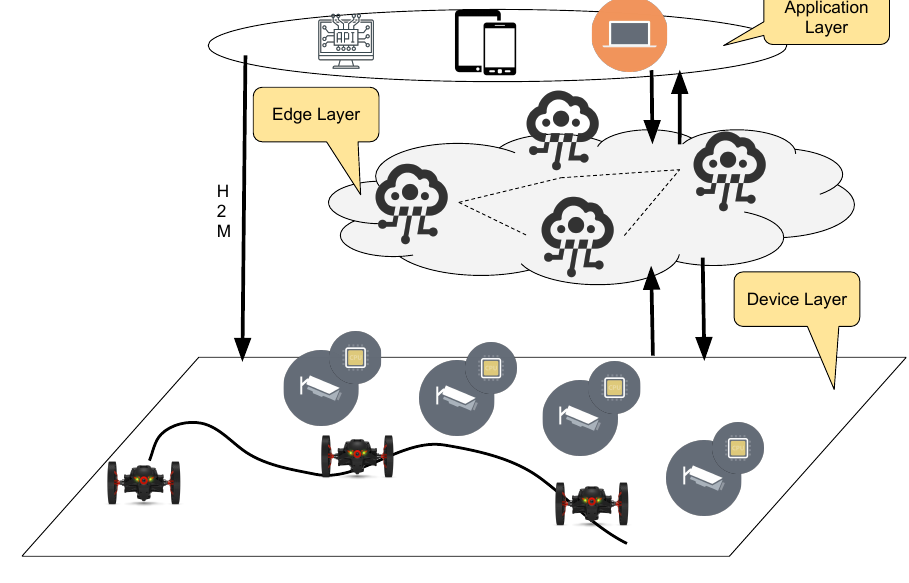
Figure 1. Decentralized reference architecture composed of a device layer, an edge layer and an application layer in which several instances can be executed for interfacing the system. Each application instance can receive the status of the